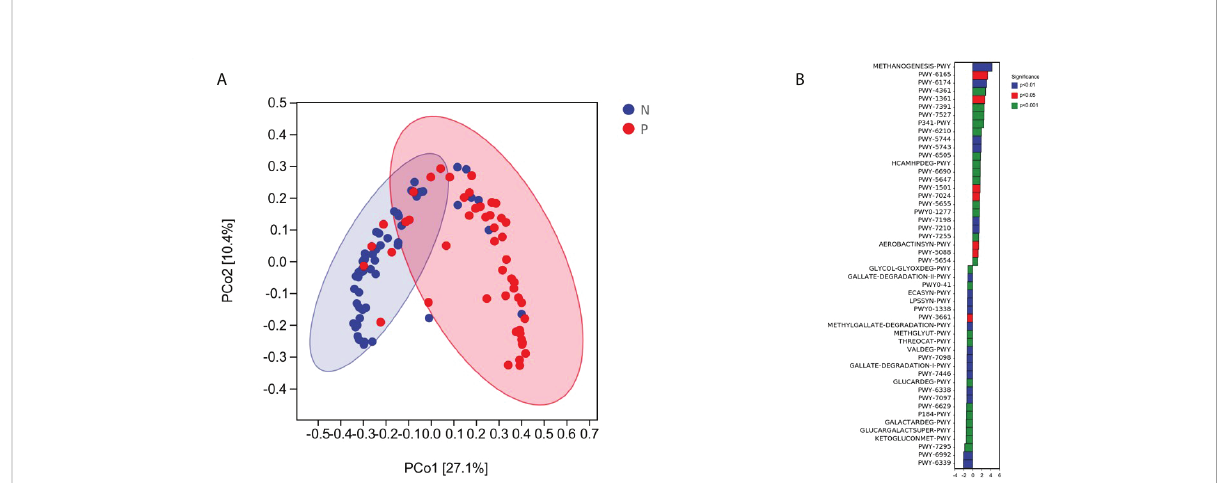
FIGURE 5 Comparisons of functions and metabolic pathways between the PPROM and term delivery groups. (A) Functional differences between groups were analyzed using principal coordinate analysis based on the Bray Curtis distance (p < 0.05). (B) Differential metabolic pathways identi fi ed by linear discriminant analysis effect size between